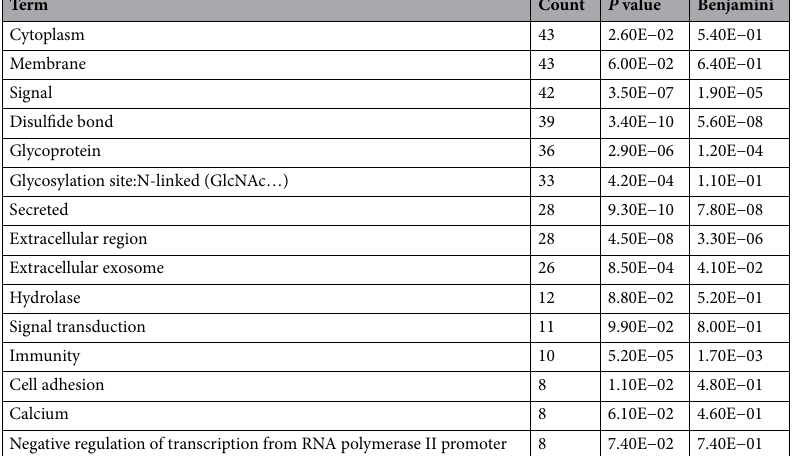
Table 3. Top functional categories affected by Hdac3 deficiency. Differentially regulated genes from high- throughput sequencing results were grouped into functional categories using the DAVID bioinformatics